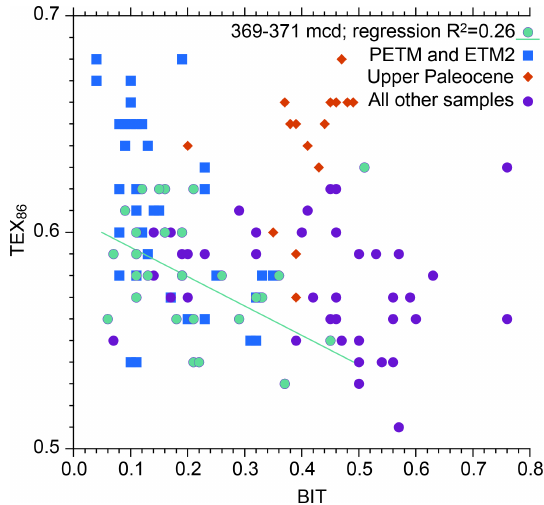
Figure 3. Comparison of the original GDGT dataset for the upper Paleocene and lower Eocene of ACEX Hole 4A (Sluijs et al., 2006; Sluijs et al., 2009) and the new data generated according to the latest chromatography protocols.